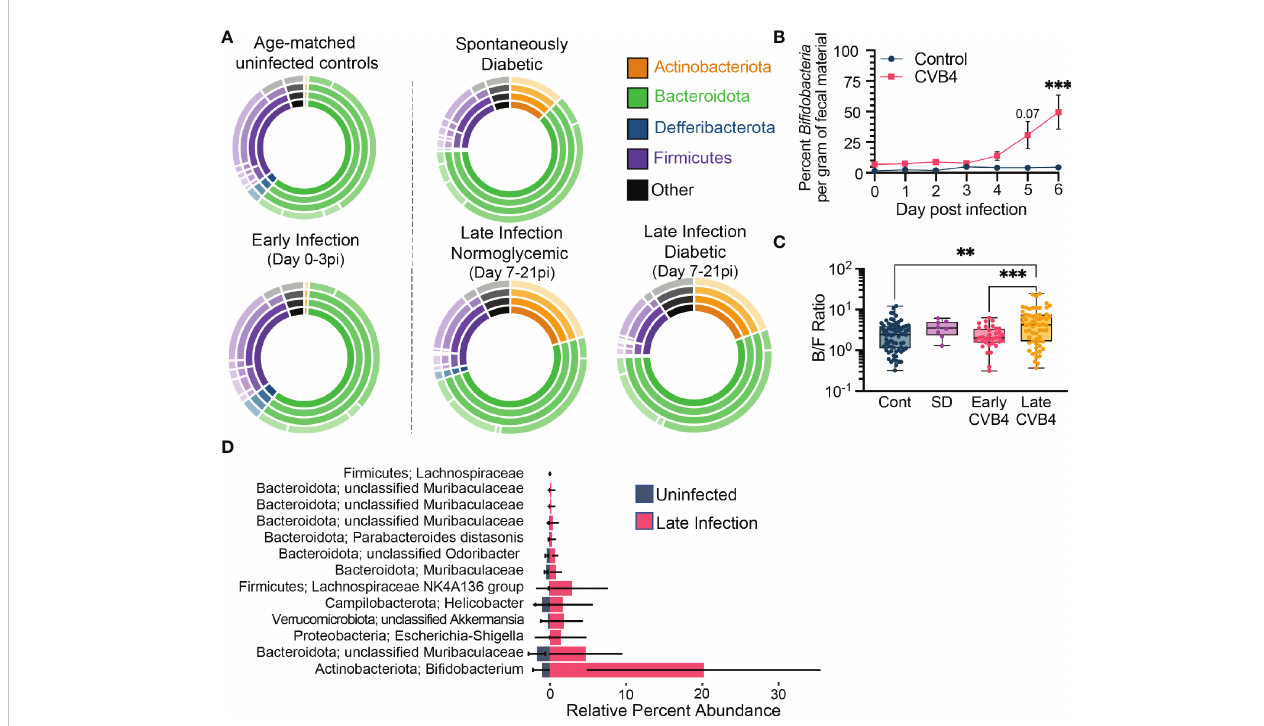
FIGURE 2 Bacterial Indicators of CVB4-induced Dysbiosis Associated with T1D (A) The relative abundance of bacterial taxa within experimental groups. Inner rings indicate composition on a phylum level and each subsequent ring represents a lower taxonomic level (class, order, family). Uninfected (normoglycemic, days 0-21 pi, n = 72); Early infection, days 0-3 pi (n = 34); Late infection - Normoglycemic, days 7-21 pi with blood sugar <16.2 mg/dL (n = 38); Late infection - Diabetic, days 7-21 pi with blood sugar >16.2 mg/dL (n = 24); Spontaneous diabetic, no infection with blood sugar >16.2 mg/dL (n = 8). (B) Copies of Bi fi dobacteria genes per gram offecal material over the fi rst 6 days of infection as measured by qPCR. (Control n = 3, CVB4 n = 6). Data are from one experiment and analyzed by Two-Way ANOVA using S ̌ idak's multiple comparison test. (C) Ratio of Bacteroidota to Firmicutes abundance in fecal pellets of control, spontaneously diabetic (SD) and CVB4-infected mice at days 0-3 pi (early infection) and 7-21 pi (late infection). Data are from 3 independent experiments and represented as mean ± range. P values were calculated using Welch's ANOVA with Dunnet's T3 multiple comparisons test. (D) Lefse analysis displaying indicator bacterial species associated with uninfected control samples vs. late infection timepoints (Day 7-21pi) (Uninfected n = 72, Late Infection n = 62 samples). All data are representative of at least three independent experiments unless stated otherwise. **P ≤ 0.01 was considered statistically signi fi cant; ***P ≤